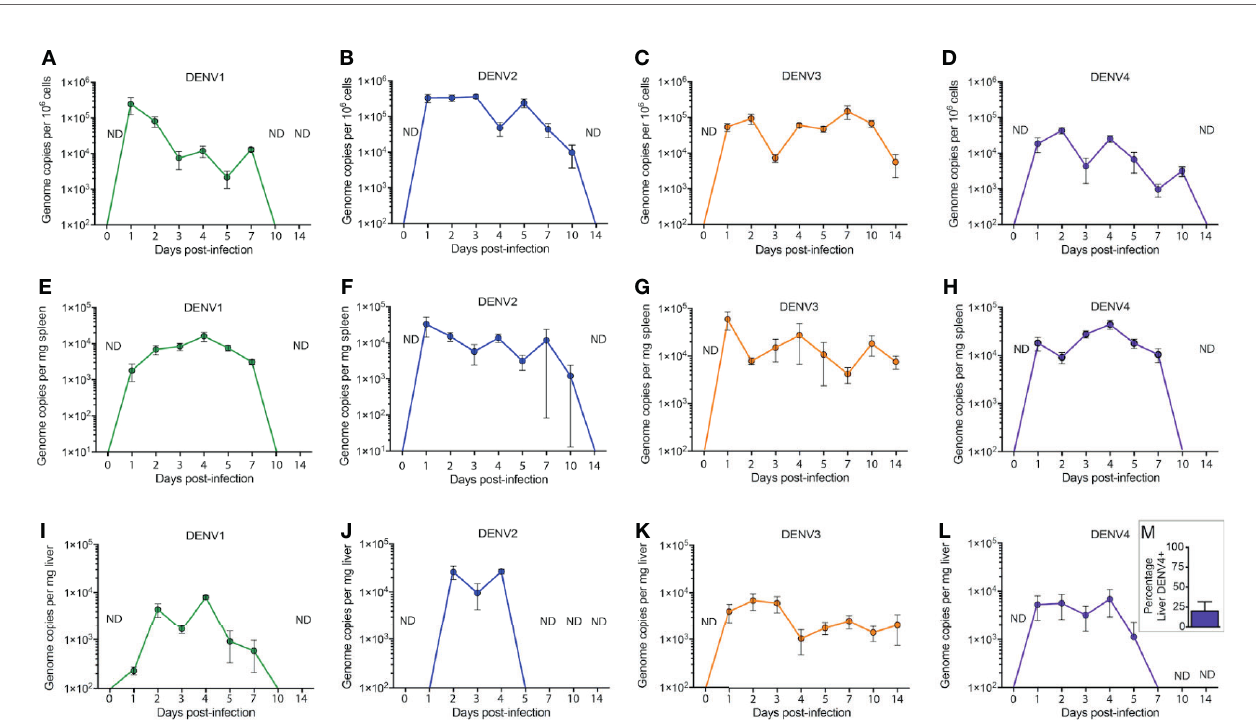
FIGURE 1 | Systemic replication of DENV1-4 in WT mice. Mice (minimum of n=5 for each time point) were injected with 1x10 6 pfu of DENV1-4 via intraperitoneal route and at various time points post-infection (days 0 to 14), cells of the peritoneum, spleen and liver were harvested for viral quanti fi cation. Quanti fi cation of viral genome copies demonstrates that viremia persisted for up to 10 days (A – D) in the cells of the peritoneum and for 5-7 days in the tissues such as the spleen (E – H) and the liver (I – M) . For (M) , the average percentage of DENV+ liver among DENV4-infected animals for three independent experiments, each with n=5 animals per experiment, is shown. Baseline values are shown as day 0. ND, not detected. The threshold of detection for all strains was approximately 10 1 , below the y-axis on the